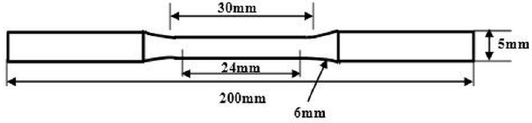
Figure 1. Tensile specimen dimensions designed according to the ASTM E8/E8M-13a 26 .